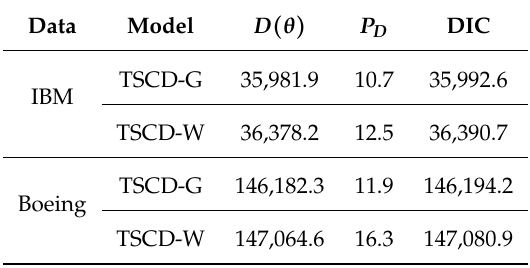
Table 5. Restricted model selection by using the observed-data DIC